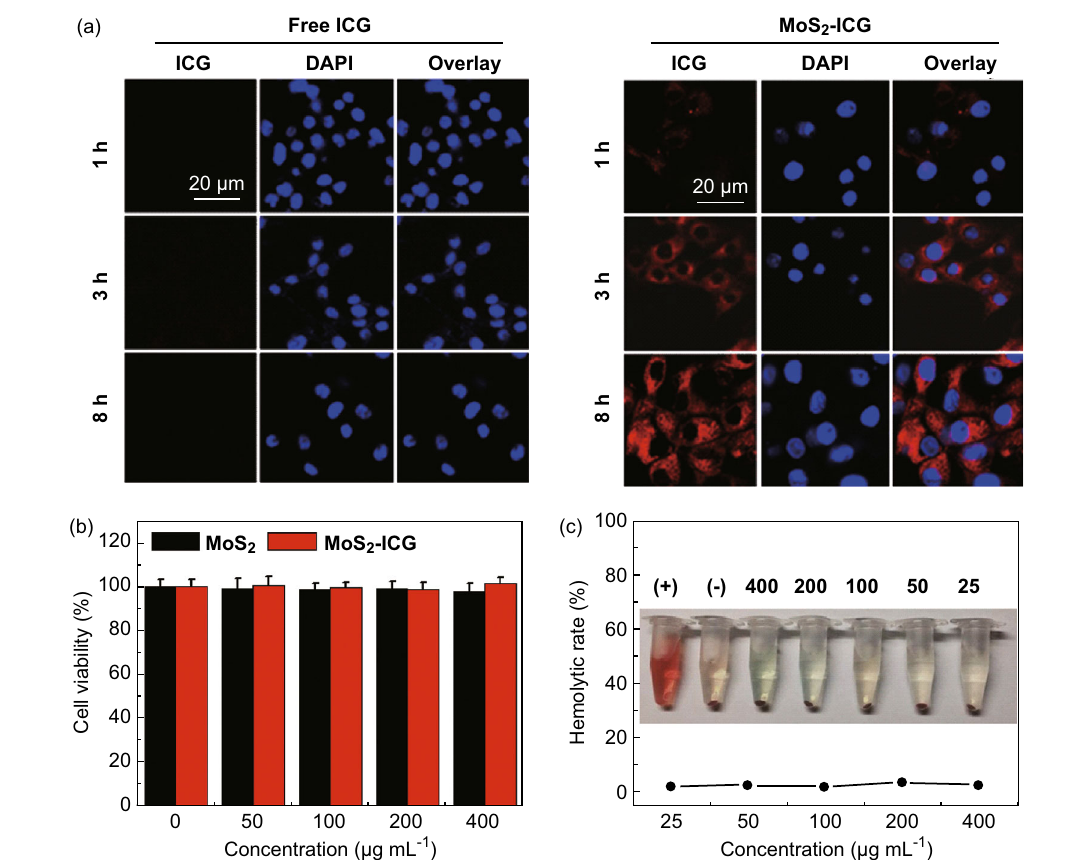
Fig. 4 a Confocal fluorescence images of U87 glioma cells incubated with free ICG and MoS 2 –ICG for 1, 3, and 8 h. Blue shows fluorescence of DAPI and red shows fluorescence of ICG. b Viability of U87 glioma cells incubated with different concentrations of MoS 2 –ICG for 24 h. c Hemolysis percentage of RBCs after treatment with different concentrations of MoS 2 –ICG for 3 h. ( ? ) and ( - ) each indicates distilled water and PBS as positive and negative controls. The inset photograph shows the direct observation of